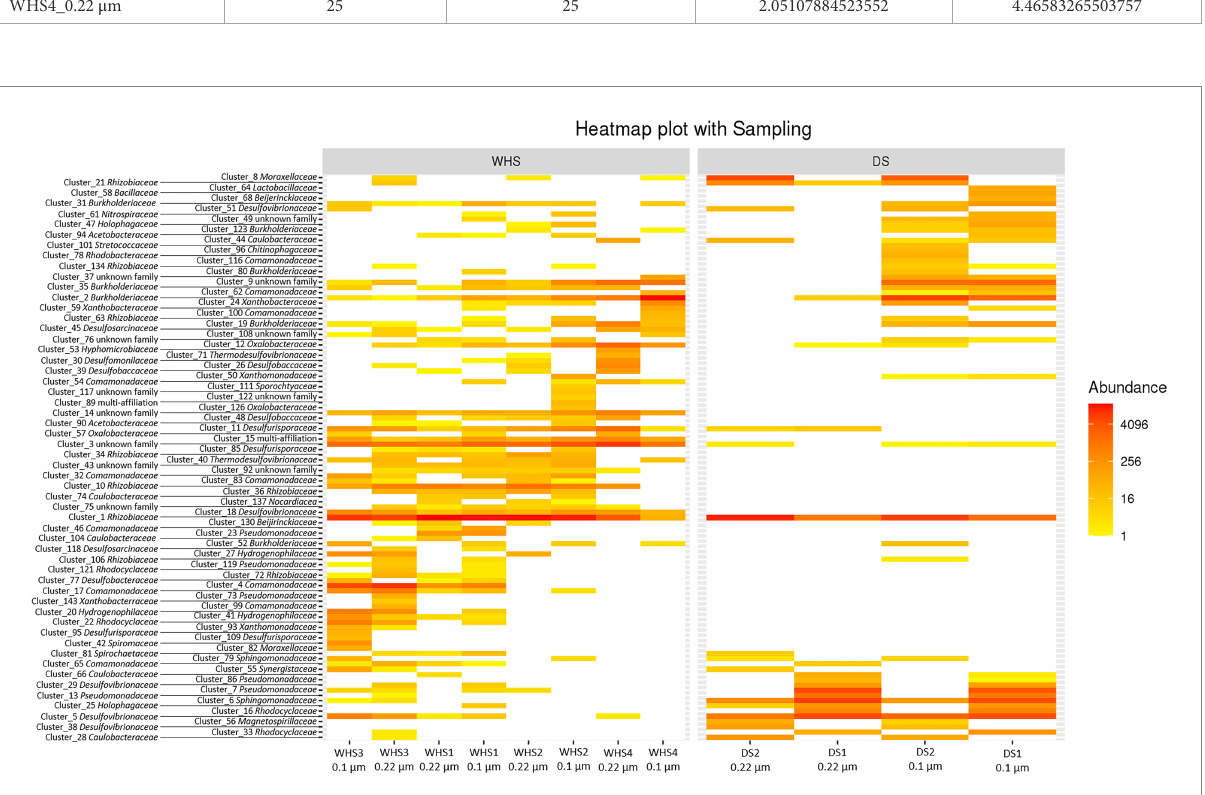
FIGURE 3 Heatmap showing the distributions of 108 bacterial OTUs in the formation water collected at the wellhead (WHS) and with the downhole samplers (DS) after a biomass concentration with filters with a porosity of 0.22 μ m and 0.1 μ m from the 0.22 μ m-eluate. The taxa associated with the OTUs are presented to the left of the figure and in Supplementary Table